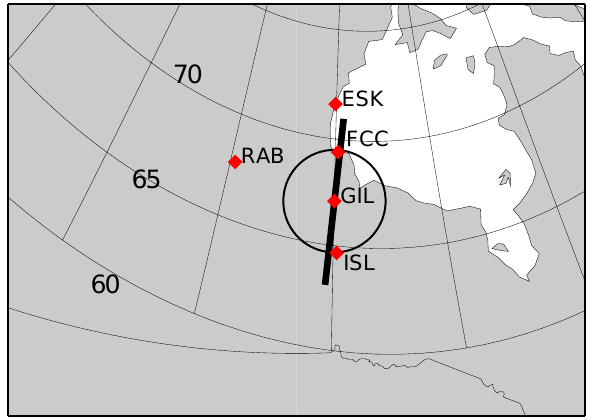
Fig. 1. The locations of the Canadian fluxgate magnetometers (red diamonds). The FoVs of the Gillam ASI and MSP are indicated by the black circle and thick black line, respectively. The contours show the PACE invariant geomagnetic latitude and longitude (Baker and Wing, 1989). The longitude contours are separated by one hour in MLT.